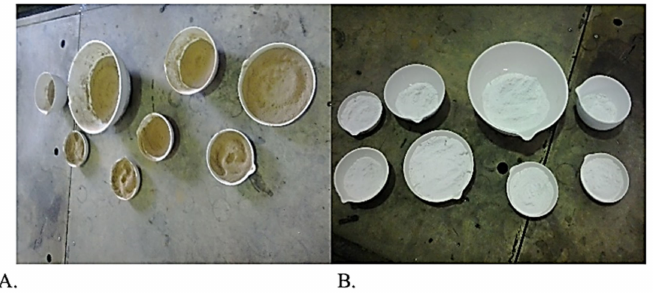
Figure 4. Ball milled RHs ( A ) before and ( B ) after the calcination process. Silicon oxide nanoparticles (NPs) were formed upon calcination.